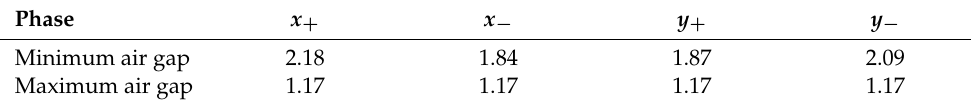
Table 4. Measured inductances (in mH) on each phase at 100